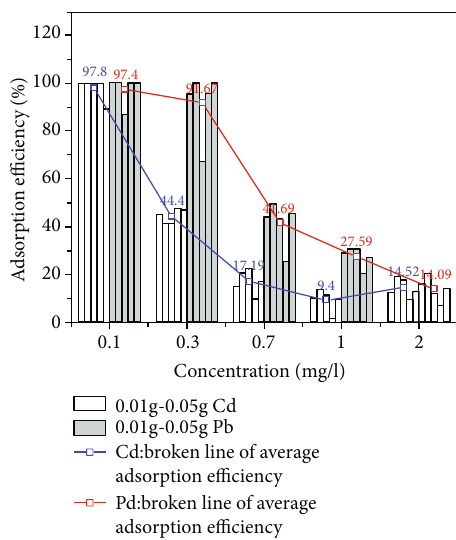
Figure 5: Adsorption e ffi ciency of microplastics to Cadmium (Cd) and lead (Pb) ( V = 20 mL, temperature at 298K, t = 48 h).